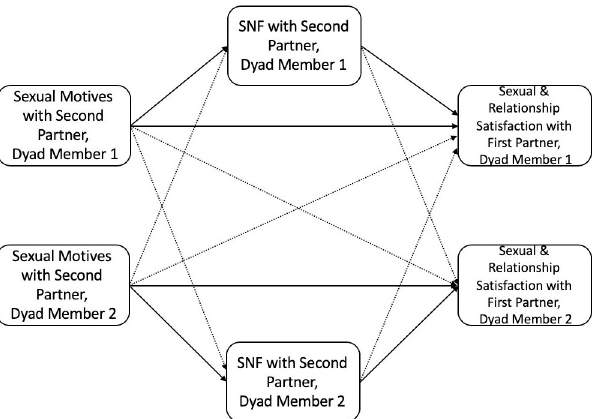
Fig 2. SDT model for sexual motives and sexual need fulfillment with a second partner, and sexual/relationship satisfaction in the primary dyad. Notes: Solid lines indicate actor effects; dashed lines indicate partner effects; dyad members include CNM partners living with one another (often considered a “primary” partner, referred to as “first partner” in Fig 2); “Second Partner” refers to another sexual partner that the person reported on who did not complete the study (i.e., is not a member of the dyad being analyzed); SNF = sexual need